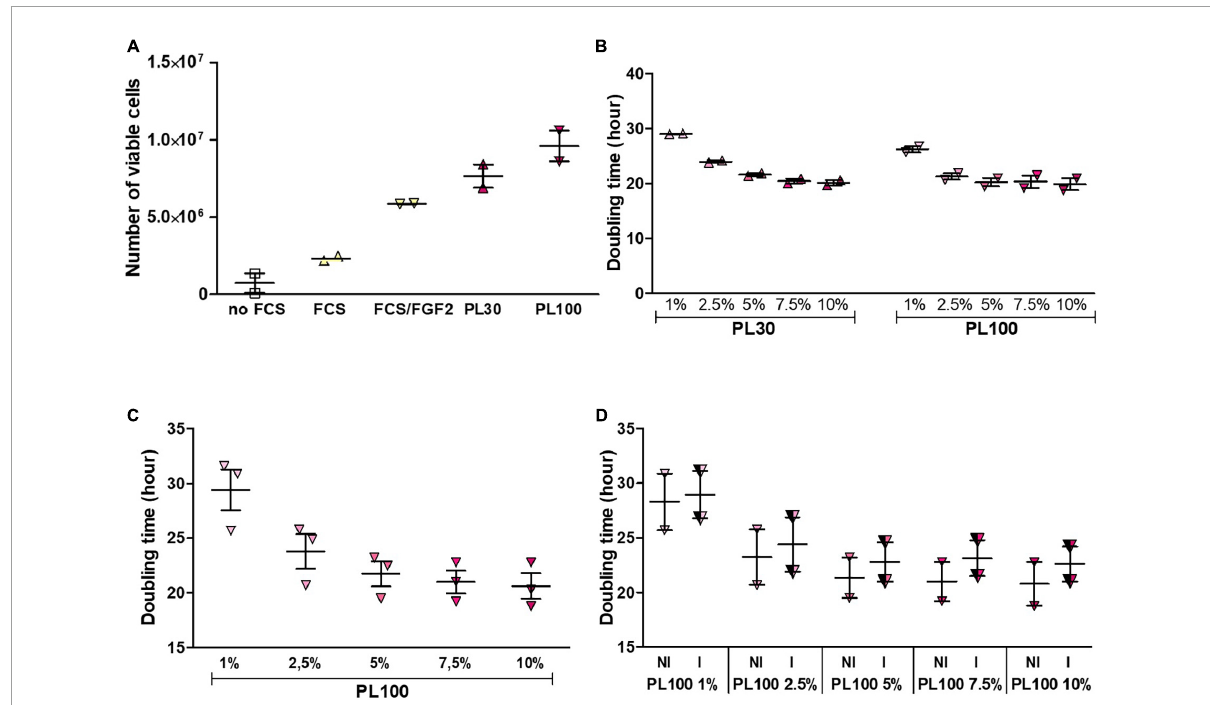
FIGURE3 Comparison of culture conditions on cell proliferation. (A) Effect of platelet lysate on cell proliferation from a single donor was compared with standard medium including 10% fetal calf serum ( n = 2). (B) In addition, no variability between the two tested batches – PL30 versus PL100 – is noticeable Comparison of five concentrations of platelet lysates on cell proliferation. A trend toward a reduced doubling time with increasing platelet lysate is observed ( n = 2). (C) Effect of platelet lysate on cell proliferation from three donors. No statistically significant difference is observed ( n = 3). (D) Effect of the sterilization procedure on cell proliferation. Gamma irradiation has no detrimental effect on doubling time ( n = 3). I, irradiated; NI,